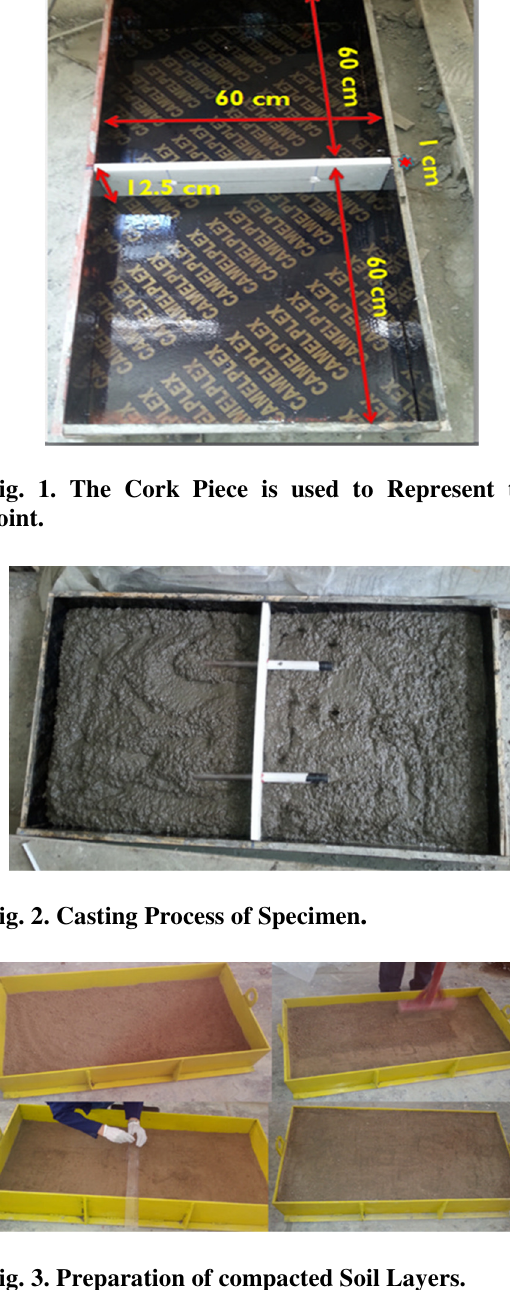
Fig. 3. Preparation of compacted Soil Layers.